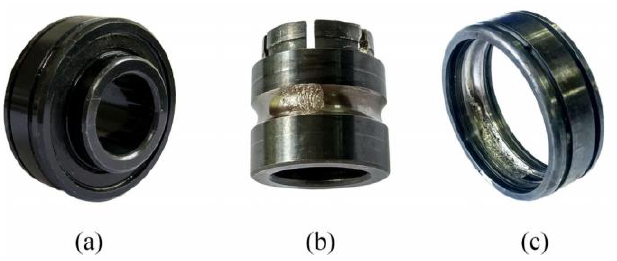
Figure 3. Photos of tested bearings: ( a ) Normal bearing, ( b ) Inner race wear and ( c ) Outer race wear.